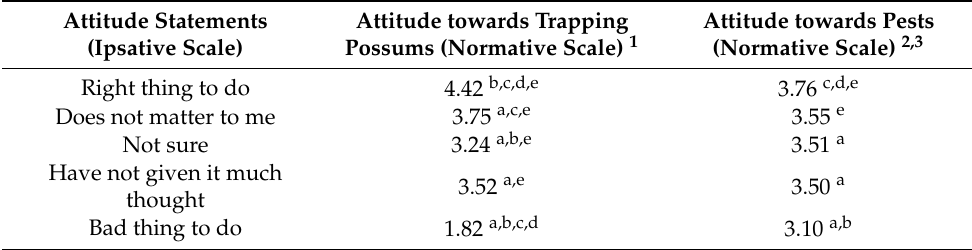
Table 6. Consistency in attitudes towards trapping